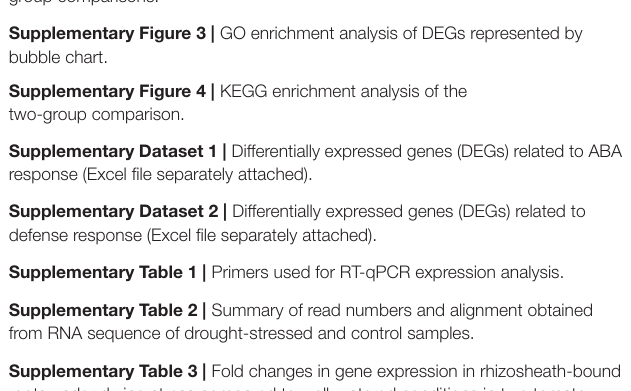
wild-type plants growing under well-watered conditions, (E) root hair analysis as determined using the Image J software, and (F) root length as determined by the WinRhizo program. Supplementary Figure 2 | GO enrichment analysis of the DEGs in two different group comparisons. Supplementary Figure 3 | GO enrichment analysis of DEGs represented by bubble chart. Supplementary Figure 4 | KEGG enrichment analysis of the two-group comparison.